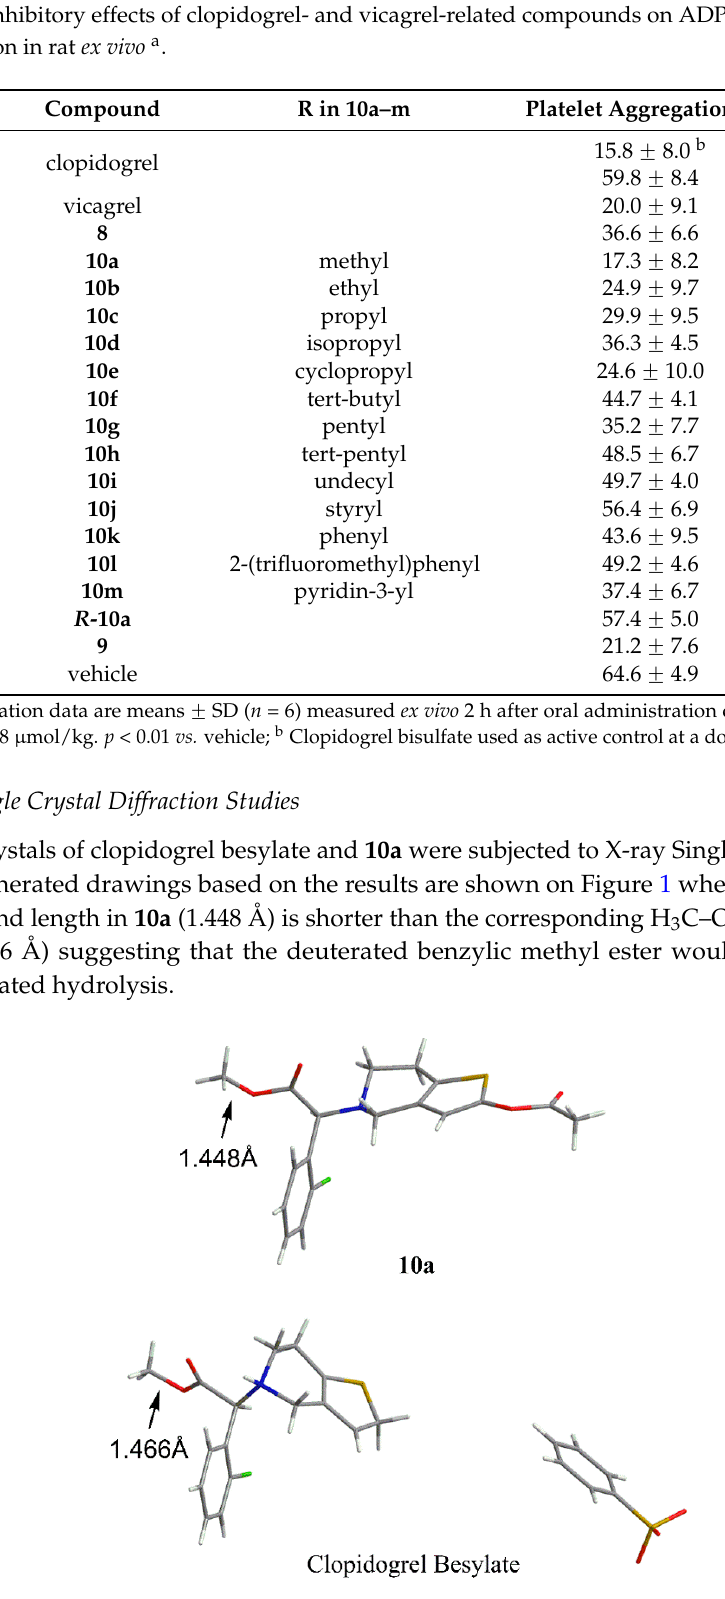
Figure 1. Computer-generated drawing of 10a and clopidogrel besylate derived from X-ray single crystal diffraction data.